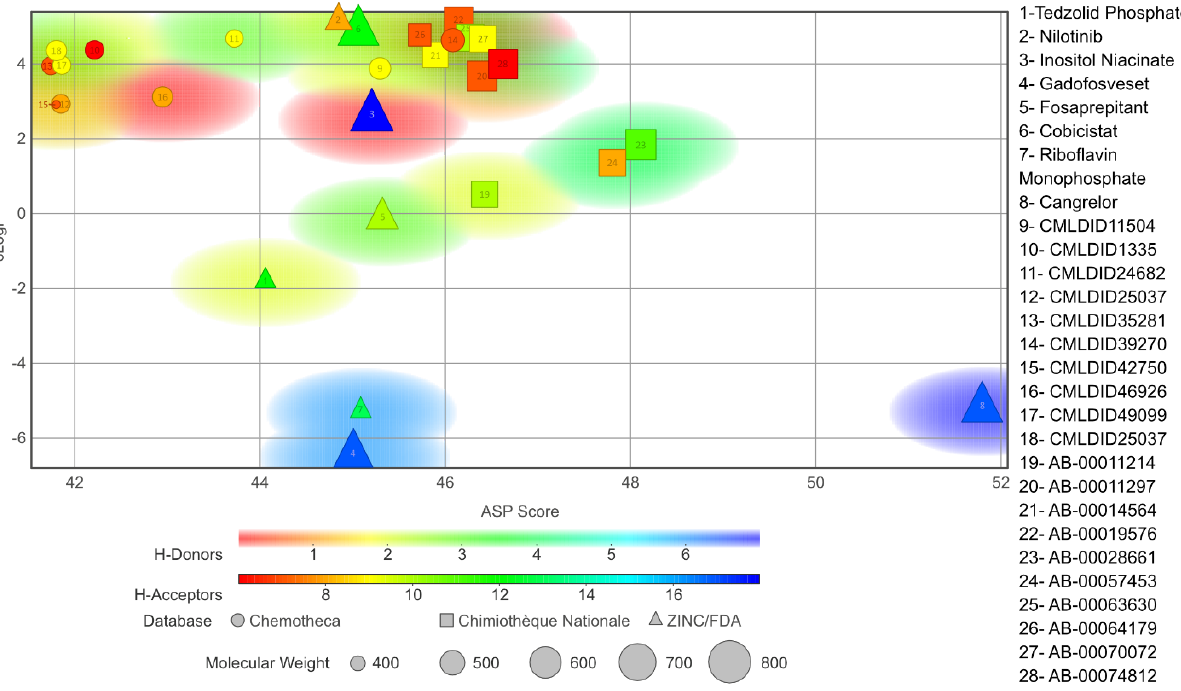
Figure 5. Graph displaying the physico-chemical diversity of the molecules selected for the MD simulations.